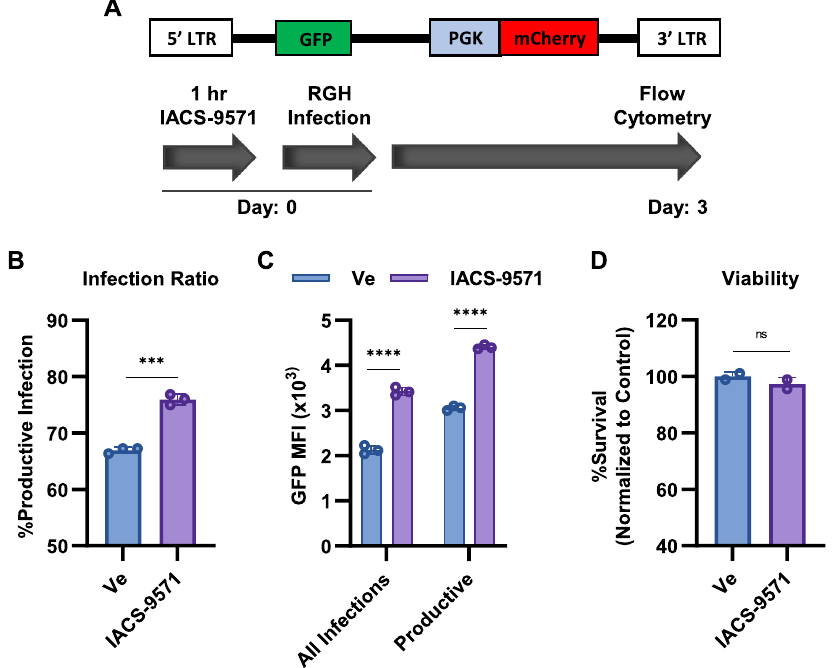
Figure 2. IACS-9571 stimulates HIV-1 expression in primary CD4 + T cells. ( A ) CD4 + T cells were pre-treated for one hour with vehicle control or 10 μM IACS-9571 and subsequently infected with RGH; flow cytometry was performed 3 days later. ( B ) The proportion of productively infected CD4 + T cells following 3 days treatment with 10 μM IACS-9571 or vehicle control is shown. Error bars represent standard deviation of 3 measurments. ( C ) As in Panel B but evaluating the Mean Fluorescence Intensity (MFI) of GFP expression. The GFP MFI was evaluated within the entire population of infected cells (All Infections) or within the population of cells that harbored productive infections (Productive). ( D ) Cells were treated as in ( A , B ) and viability was measured. Measurements were performed in duplicate with error bars representing standard